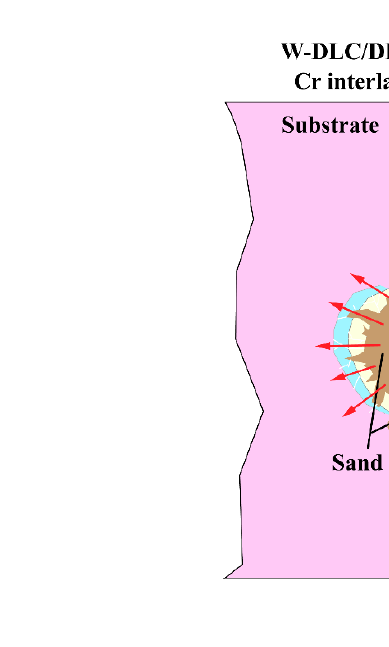
Figure 12. The impact mechanism of Cr/W-DLC/DLC multilayer under ( a ) no-sand condition and ( b ) sand condition.